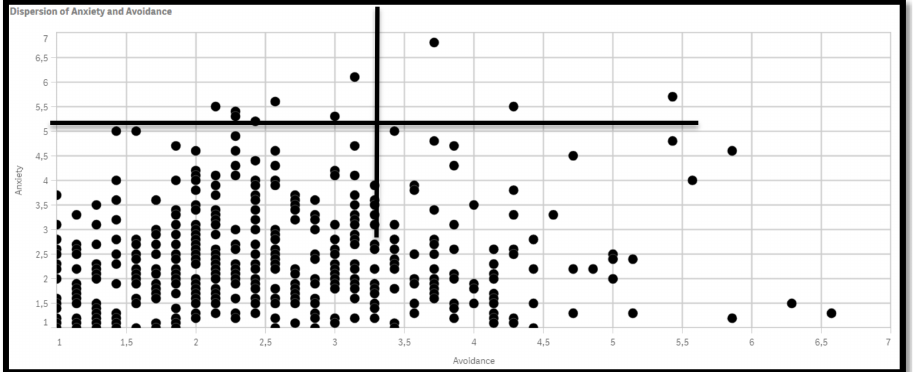
Figure 1. Dispersion of Anxiety and Avoidance Rates. Source: data study